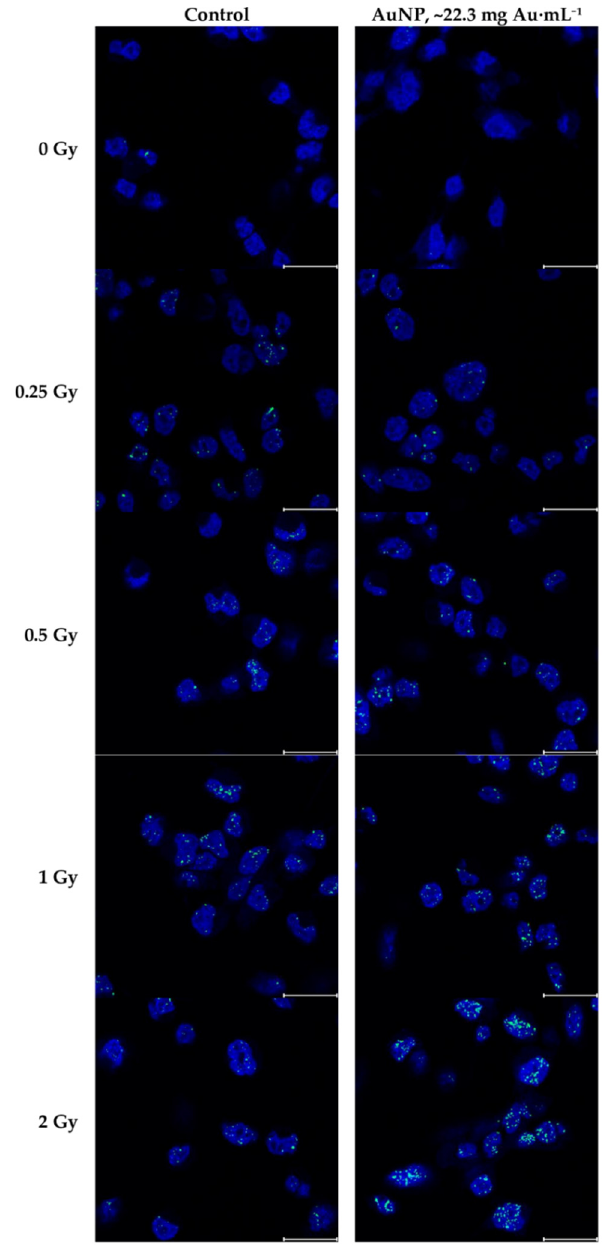
Figure 6. Fragments of the immunofluorescence images analyzed, both control and AuNP-treated, irradiated under different doses. Blue channel represents nuclei with DAPI staining, green channel represents γ H2AX labeled with Alexa Fluor 488 secondary antibodies. Blue channel window level is [0 255]; green channel window level is [140 255], representing the window level applied for foci quantification. The scale bar corresponds to 20 µm.